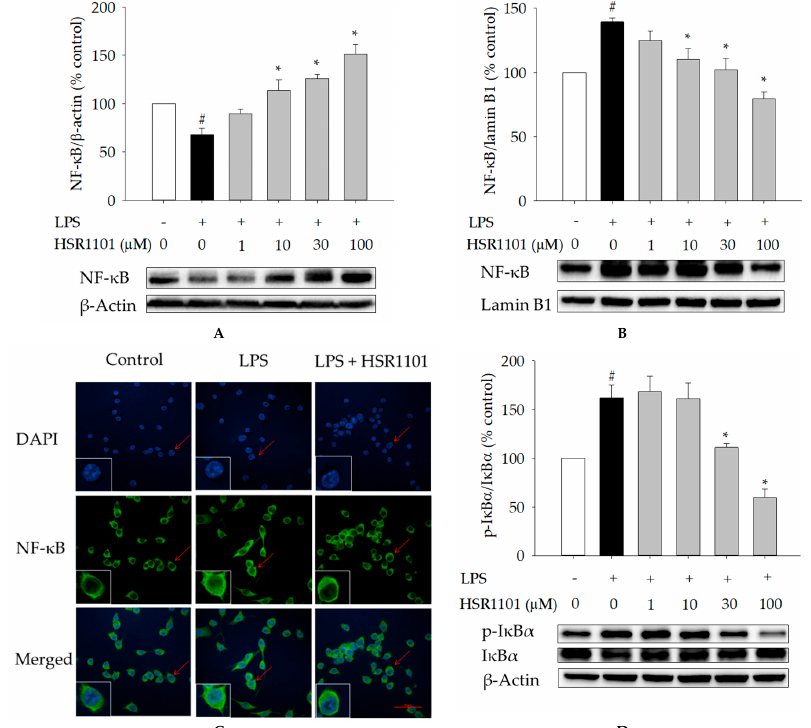
Figure 5. HSR1101 inhibited LPS-induced nuclear translocation of NF- κ B through suppression of I κ B α phosphorylation in BV2 cells. BV2 cells were co-treated with 1 µg/mL LPS and a series of concentrations of HSR1101 for 24 h. Western blotting analyses for cytosolic ( A ) and nuclear ( B ) extracts were conducted using anti-NF- κ B p65 subunit antibody. β -Actin and lamin B1 were used for normalizing cytosolic and nuclear NF- κ B, respectively. Immunofluorescence images show inhibition of NF- κ B translocation by HSR1101 ( C ). The red arrows indicate the magnified cells shown in each image. Scale bar, 50 µm. Western blotting analyses were conducted using anti-phospho-I κ B α and anti-I κ B α antibodies ( D ). β -Actin was used for normalizing phosphor-I κ B α . Representative blots are displayed. Data are expressed as mean ± SEM of at least three independent experiments. # p < 0.05 and * p < 0.05 vs the vehicle-treated control and LPS-treated groups, respectively. LPS, lipopolysaccharide; NF- κ B, nuclear factor-kappa B; I κ B α , inhibitor of kappa B alpha.